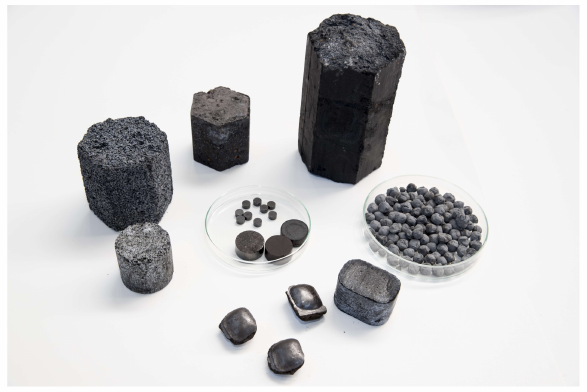
Figure 4. Exemplar of cold-bonded briquettes, agglomerates and pellets produced at VDEh-Betriebsforschungsinstitut